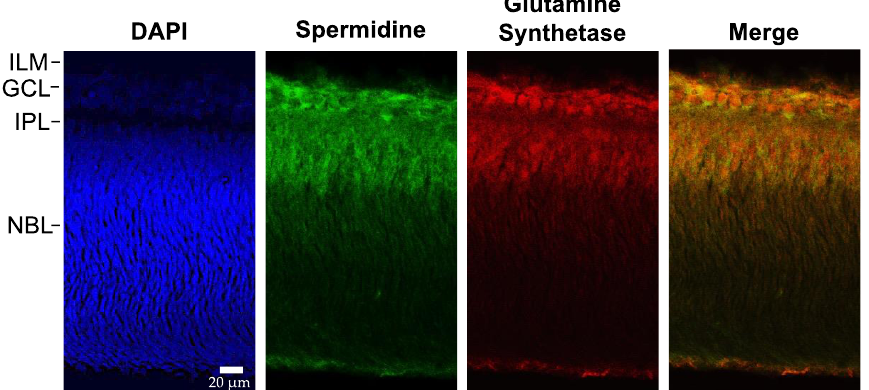
Figure 1. Spermidine (SPD) and Glutamine Synthetase (GS) immunolabeling in a 3-day-old (newborn: P3) rat retina. DAPI (blue) is a nuclear stain. SPD (green) is expressed in the neuroblast layer (NBL) surrounding cell nuclei and within the soma of some cells in the outermost part of the NBL. The SPD expression in these cells is co-localized with glial marker GS (red). Co-localized staining (merged, yellow). SPD is also expressed in the inner plexiform layer and in the ganglion cell layer, surrounding the cells. (GCL—Ganglion Cell Layer; IPL—Inner Plexiform Layer; NBL—Neuroblast Layer, proliferative zone of the inner optic cup that consists of retinal progenitor cells).